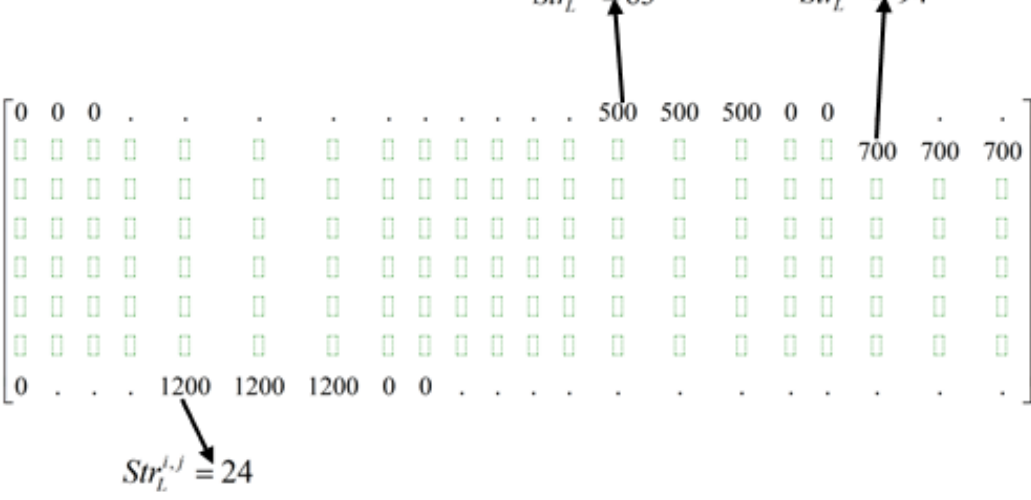
Figure 7. Re-computation of str i , j